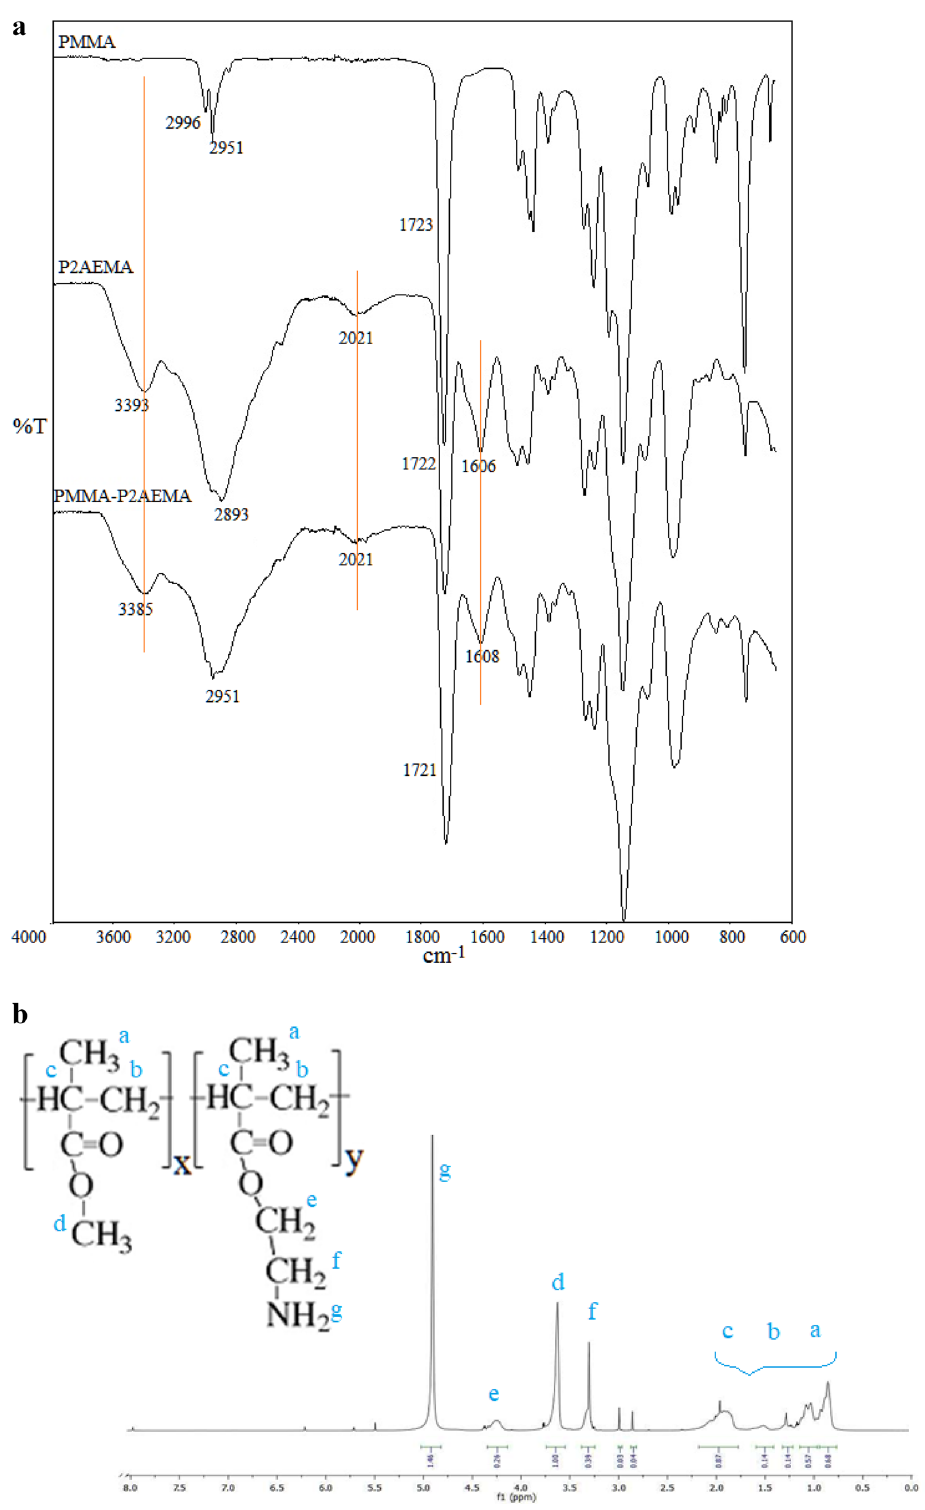
Figure 1. ( a ) FTIR spectra of PMMA, P2AEMA and Poly(MMA-co-AEMA). ( b ) 1 H NMR spectrum of the amine functionalized amphiphilic copolymer